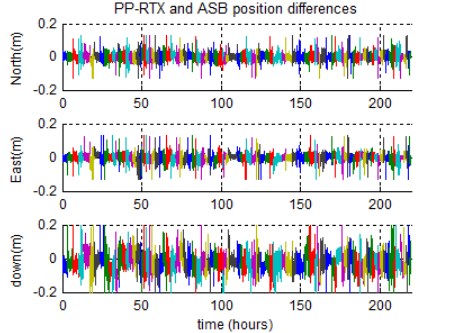
Figure 5: Position Difference, PP-RTX vs. ASB